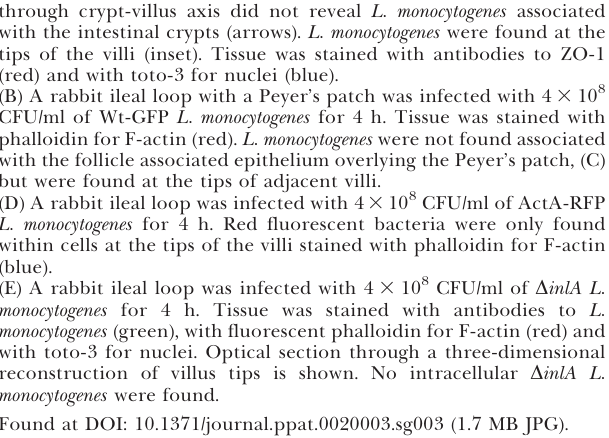
Figure S1. Preservation of Barrier Function during L. monocytogenes Infection of MDCK Cells Polarized on Transwell Filters